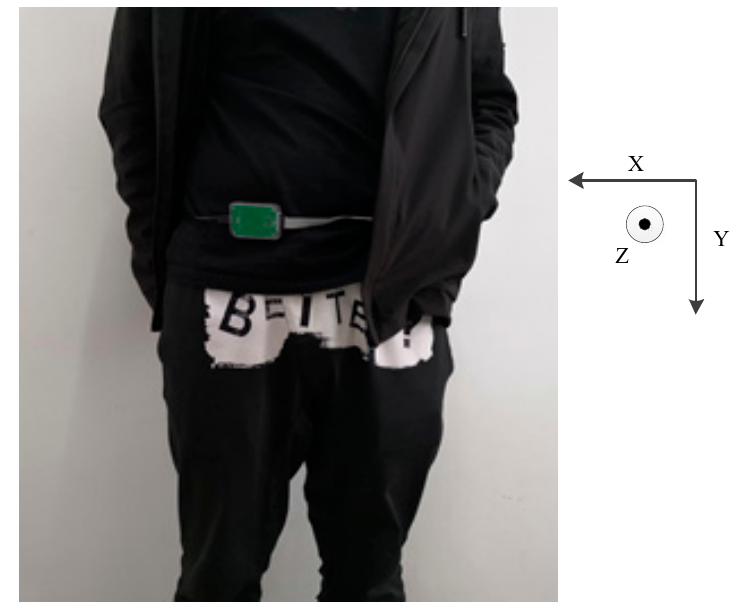
Figure 1. Wearing of accelerometer and directions of coordinate axes.